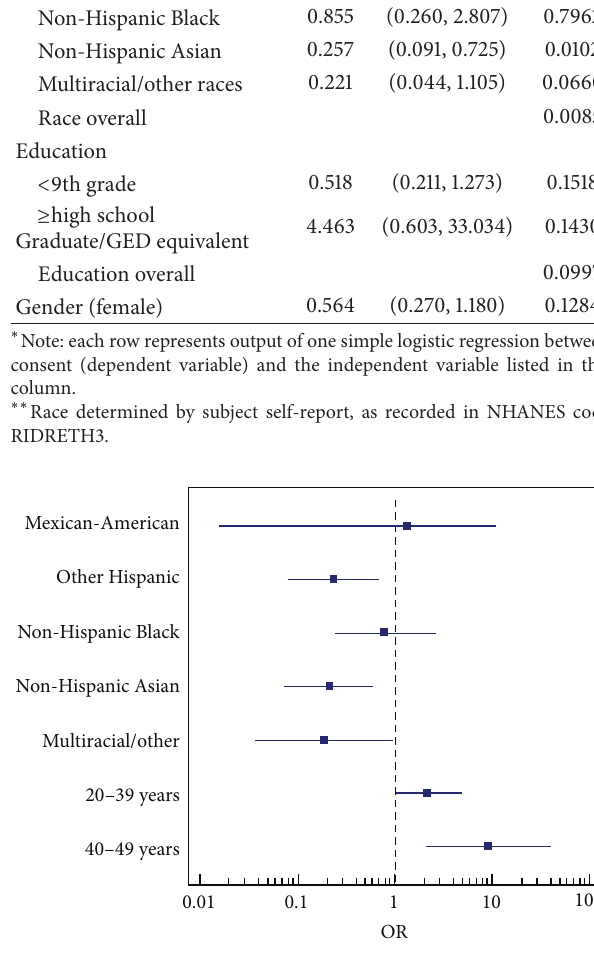
Figure 2: Odds ratios and 95% CI of each predictor of